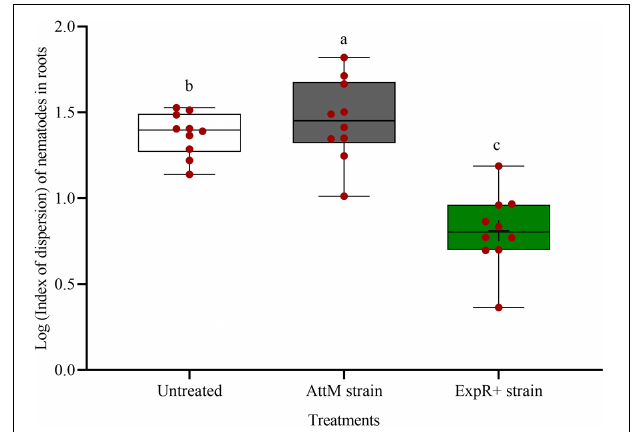
FIGURE 3 | Spatial dispersion of invaded Pratylenchus penetrans inside the roots of soybean plants primed with Ensifer meliloti ExpR + producing oxo-C14-HSL compared to roots of non-primed soybean inoculated with the lactonase-expressing strain E. meliloti AttM, or MgCl 2 as control. The coefficient of dispersion Z of P. penetrans was compared to a random (Poisson) distribution using the GLIMMIX procedure. (Tukey adjustment, log link, n = 10). Different letters indicate significant differences among